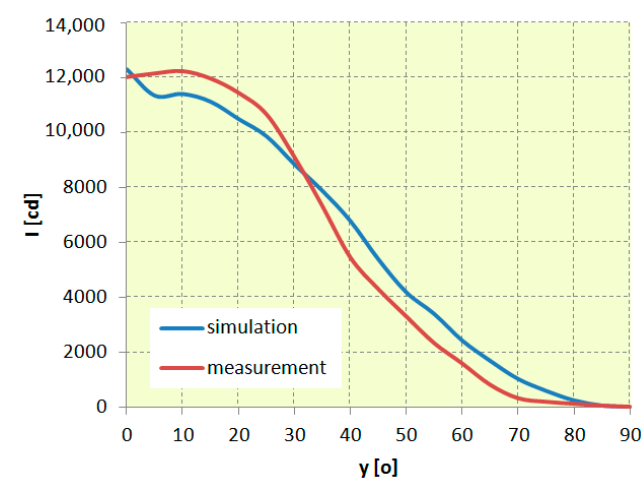
Figure 22. The comparison of luminous intensity curves of a light-optical system for narrow distribution obtained as a result of simulation and prototype measurements.